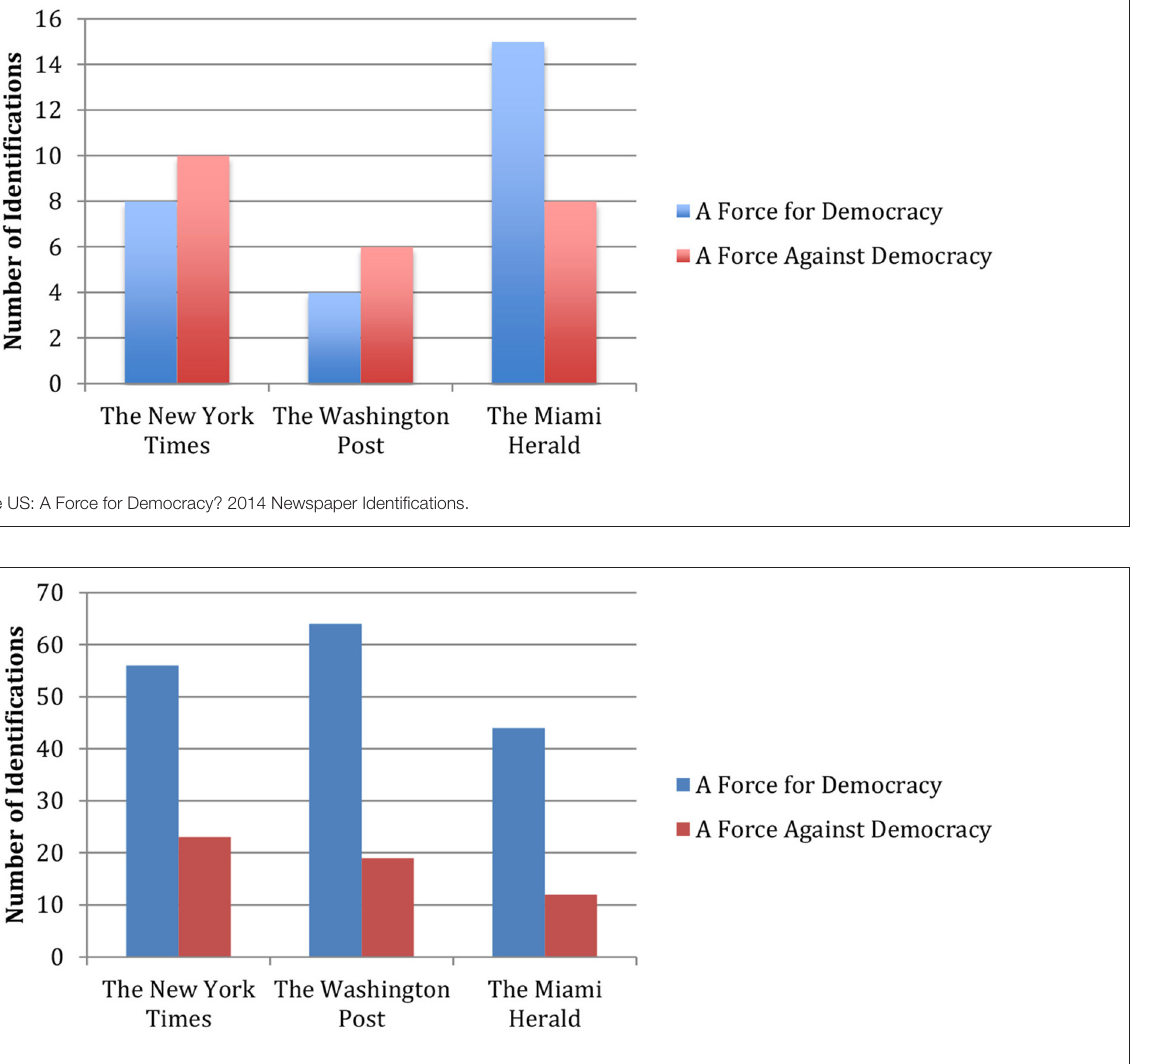
FIGURE 3 | A Force for Democracy? Identifications of the US,